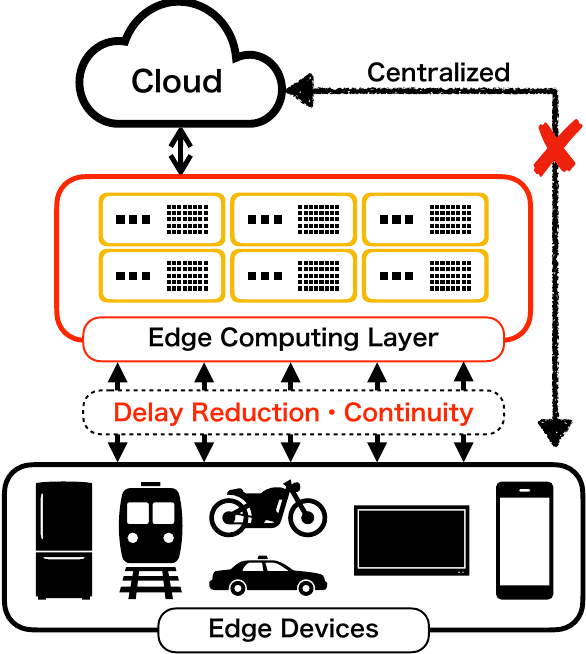
Figure 1. The structure of edge OSS